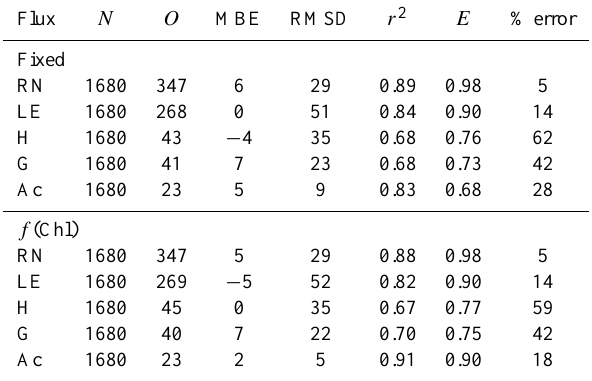
Table 3. Statistical metrics for hourly measured and modeled fluxes using two-thirds of the fields/years for validation. Energy flux units are Wm − 2 and carbon flux units are µmolm − 2 s − 1 .